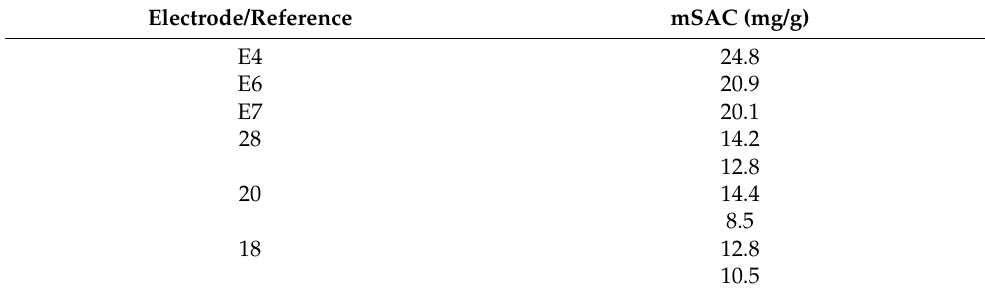
Table 5. A comparison of the maximum salt adsorption capacity (mSAC) values obtained in